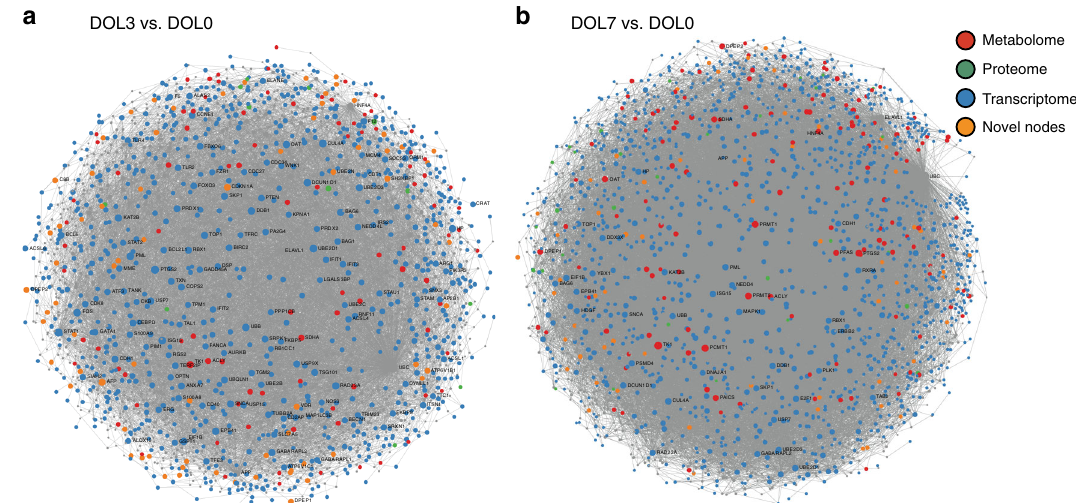
Fig. 4 Integration of multiple data types via NetworkAnalyst molecular interaction networks provided novel biological insights. Minimum-connected networks for DOL3 vs. DOL0 ( a ) and DOL7 vs. DOL0 ( b ), respectively, containing all three individual data types, where nodes derived from the transcriptome are shown in blue, nodes from the metabolome in red, and nodes from the proteome in green. Novel nodes, which are nodes that only appeared after integrating the three data types but are not present in the individual minimum network, are shown in orange. DOL: day of